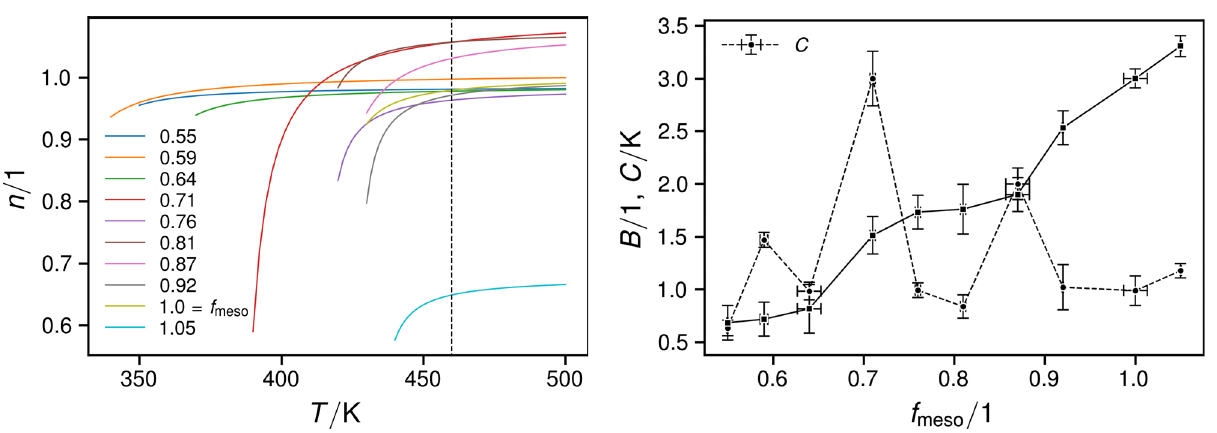
Figure 5: Progressions of the fl ow behaviour indices for each f from the measured lower temperature limits, with the dashed line marking the upper limit of actual measurements.